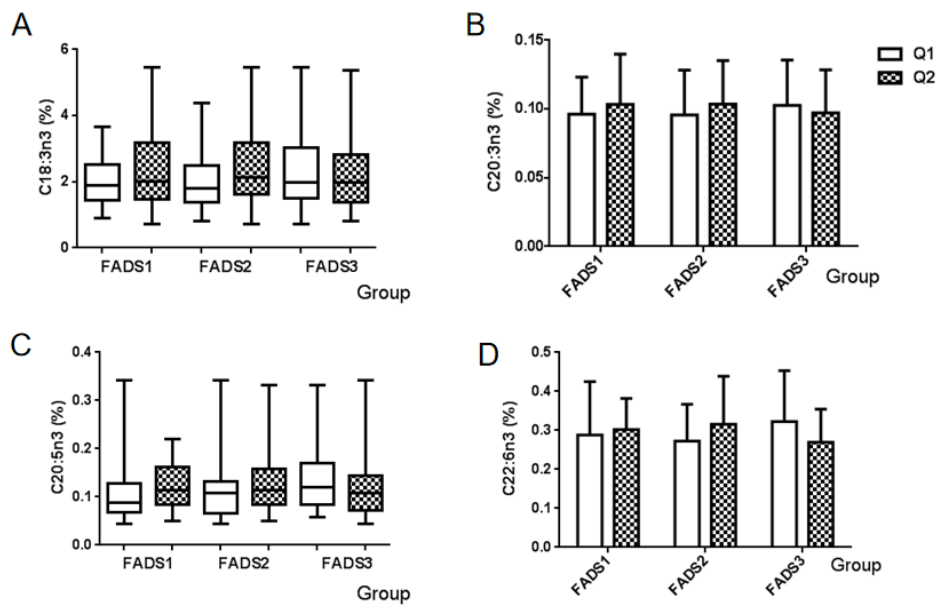
Figure 2. Association between the n-3 PUFA and mRNA expression groups of FADS genes. Values are the proportion of each n-3 PUFA of breast milk among FADS gene expression groups. ( A ) α -Linolenic acid (C18:3n3), ( B ) eicosatrienoic acid (C20:3n3), ( C ) EPA (C20:5n3), and ( D ) DHA (C22:6n3). Q1: Low mRNA expression group, Q2: High mRNA expression